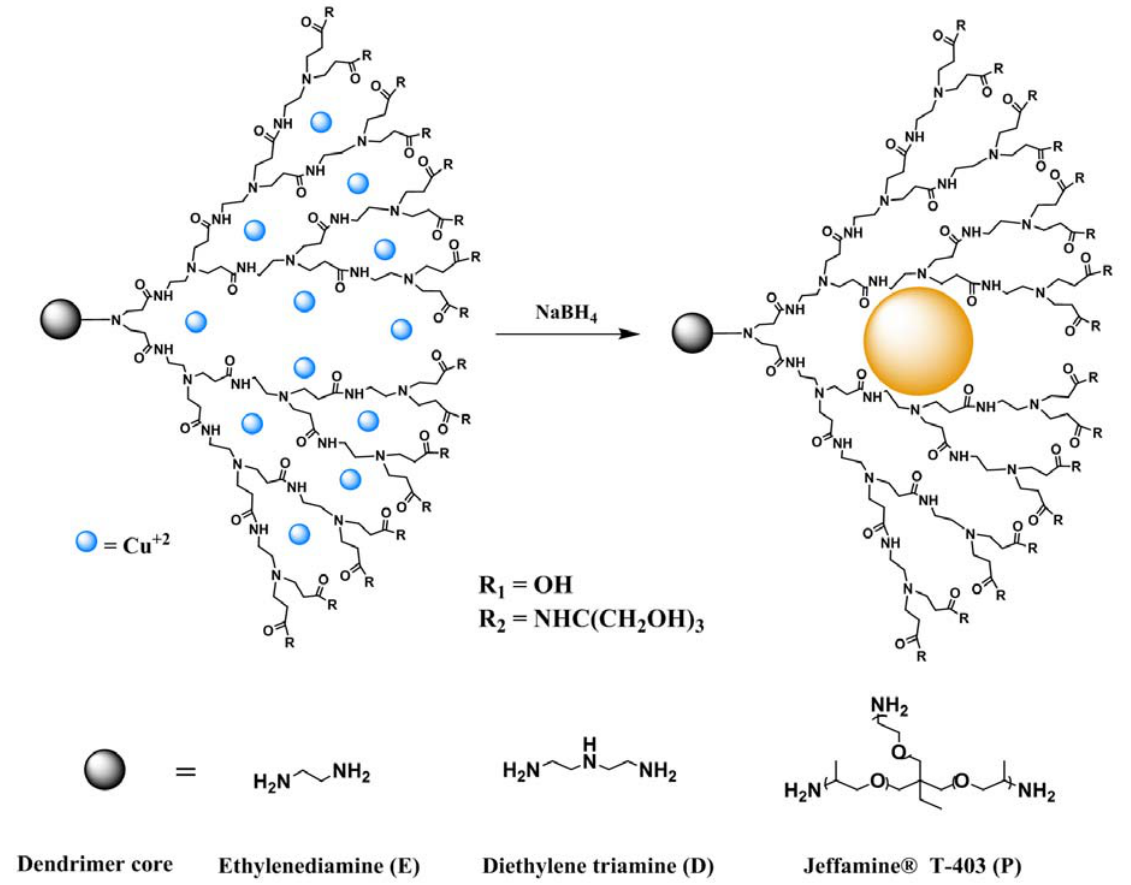
Figure 5. Synthetic route for E, D and P core PAMAM-COOH and PAMAM-TRIS